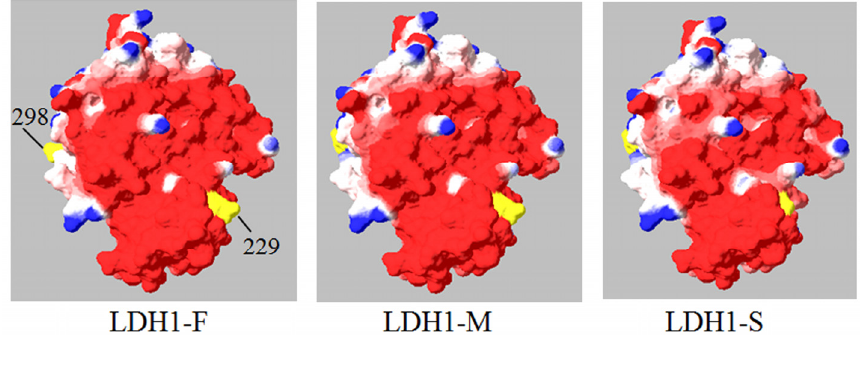
Figure 3. Charge distribution of H subunit of yak LDH1 variants. Red color represents negative charge, blue represents positive charge; the two mutations are labeled with a bright yellow color (298 Gln/Arg and 229 Glu/Ala). The areas of red color decreased from LDH1-F, LDH1-M, to